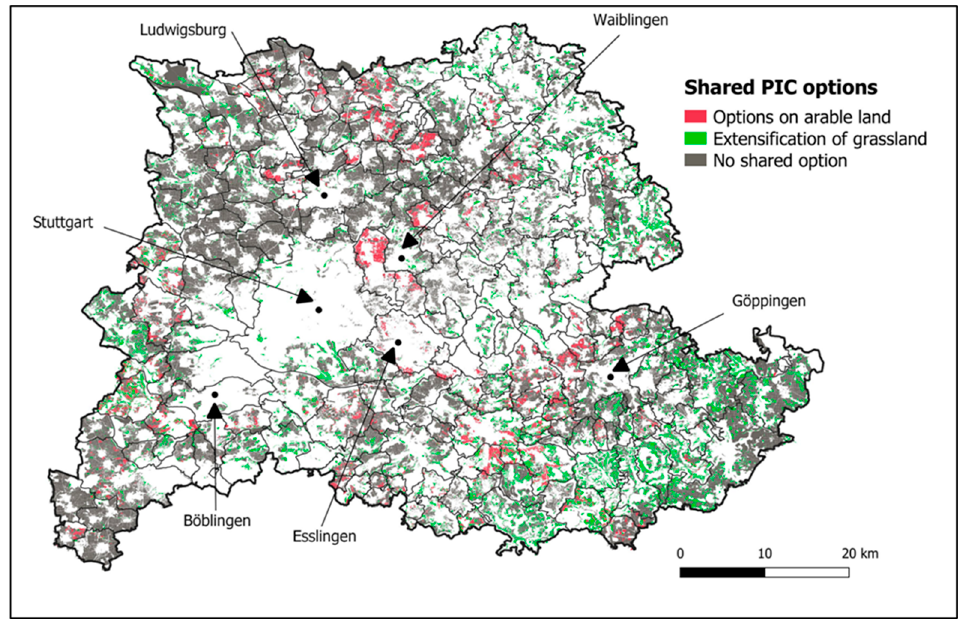
Figure 7. PIC map from both the nature conservation and agricultural perspective based on the IACS data and BKG [36]